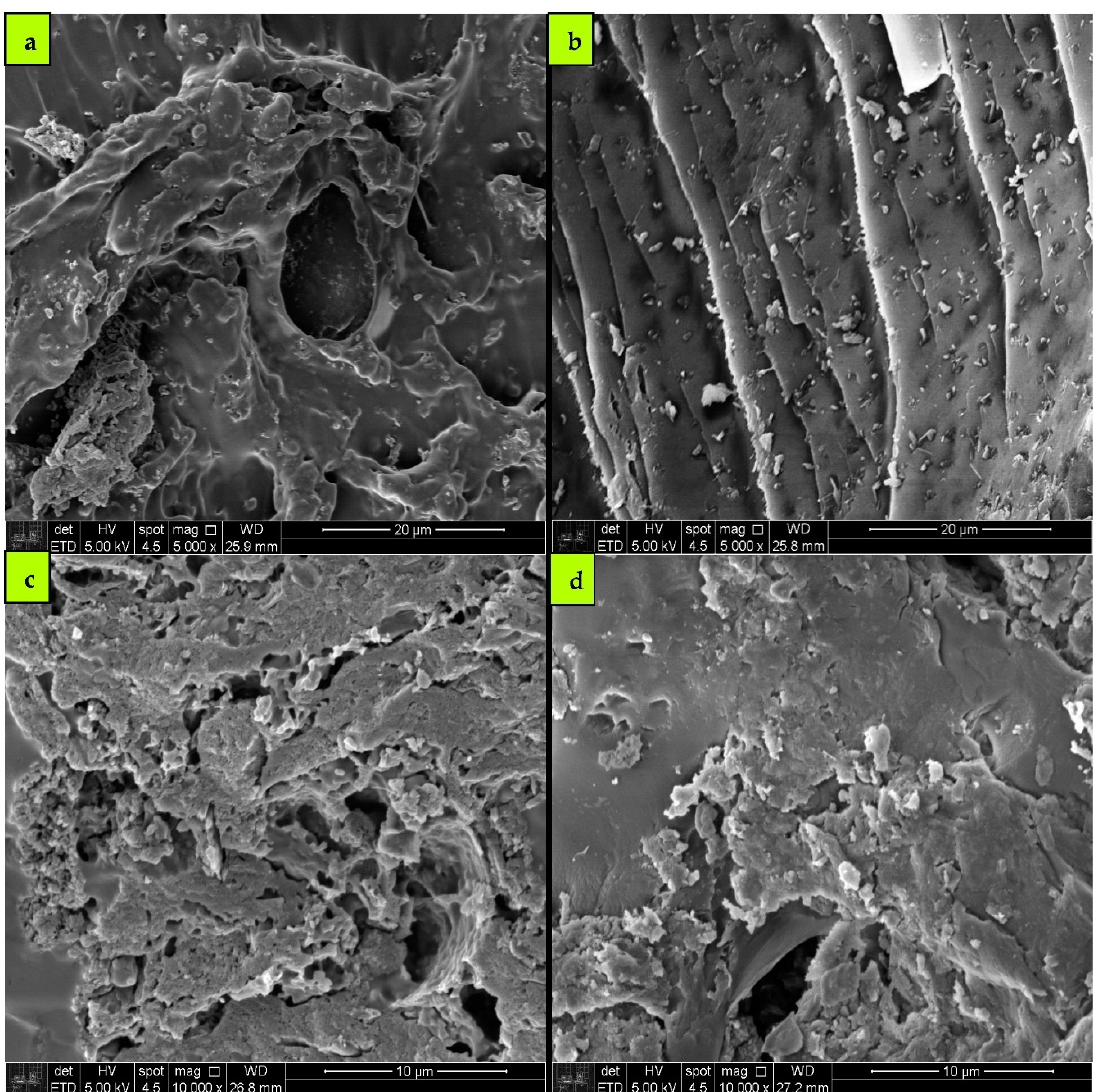
Figure 14. SEM micrographs of ( a ) SAP before MB adsorption, ( b ) SAP after MB adsorption, ( c ) SAP-AC before MB adsorption, and ( d ) SAP-AC after MB adsorption.